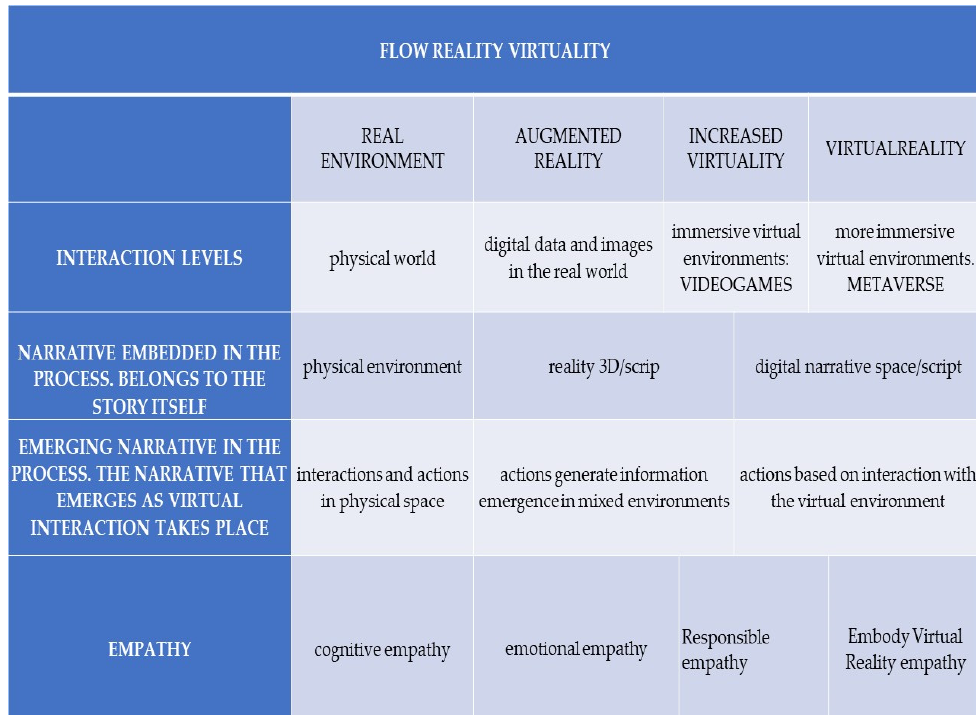
Figure 3. Flow in virtual reality.